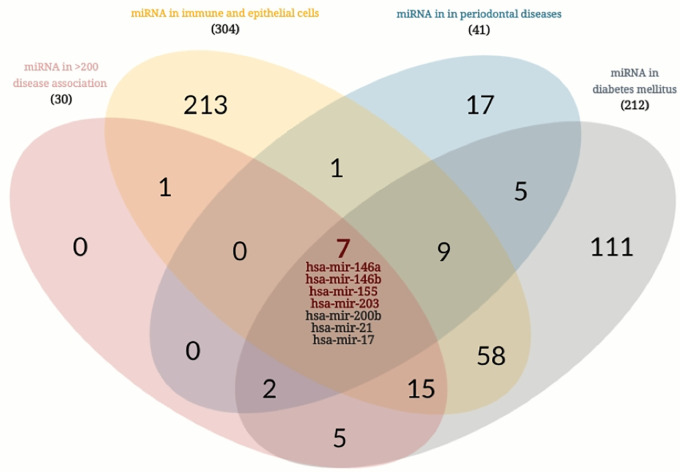
Venn diagram of bioinformatics search for candidate miRNA markers in periodontitis and diabetes mellitus.